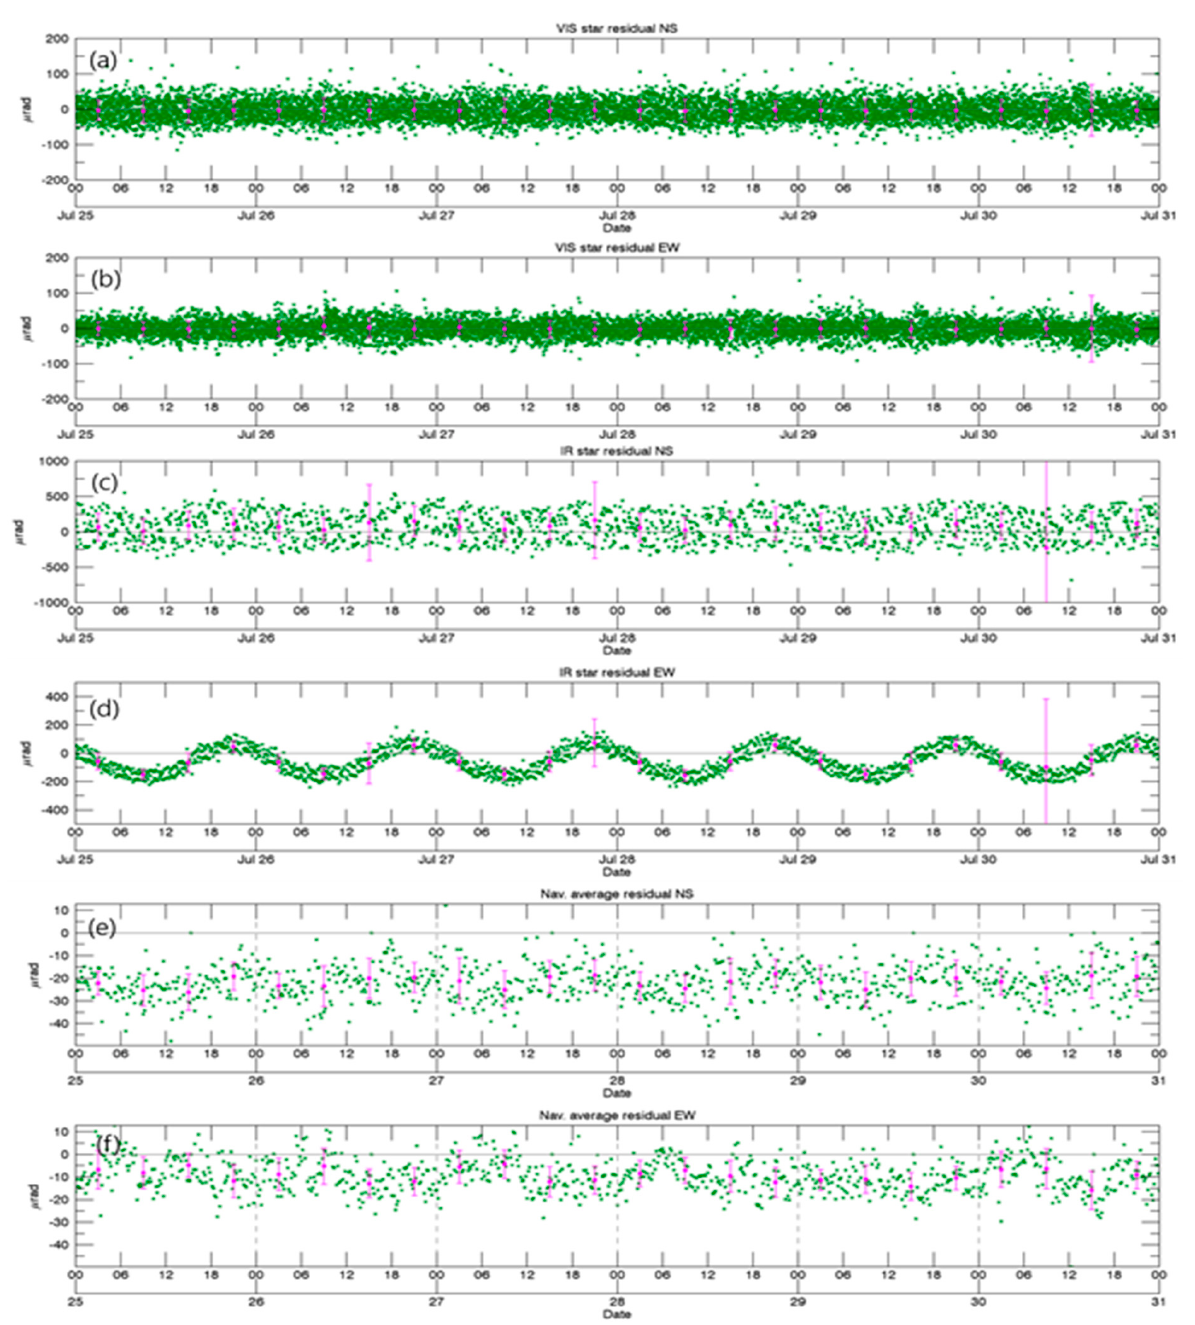
Figure 14. Visible star residual of NS ( a ) and EW directions ( b ), and IR star residuals of NS ( c ) and EW ( d ) directions. Navigation average residual of NS ( e ) and EW ( f ) from 25 to 31 July 2019.